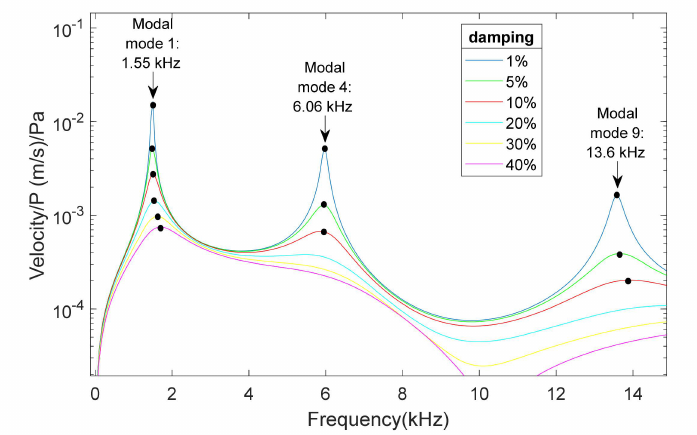
Figure 5. Center point for membranes of 60 µ m. Velocity magnitude for the positions of the source at 90 ◦ for different damping values: 1%, 5%, 10%, 20%, 30% and 40%.